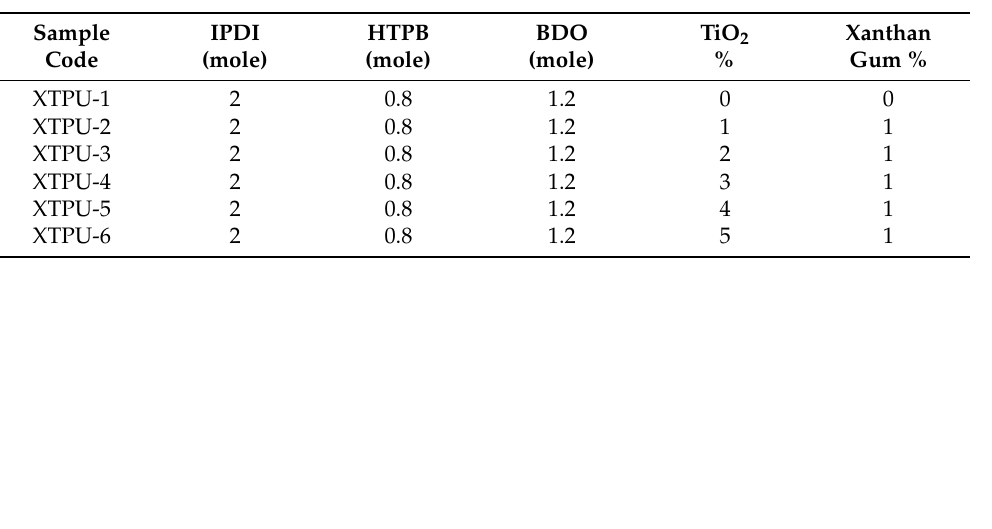
Table 1. General formulation of